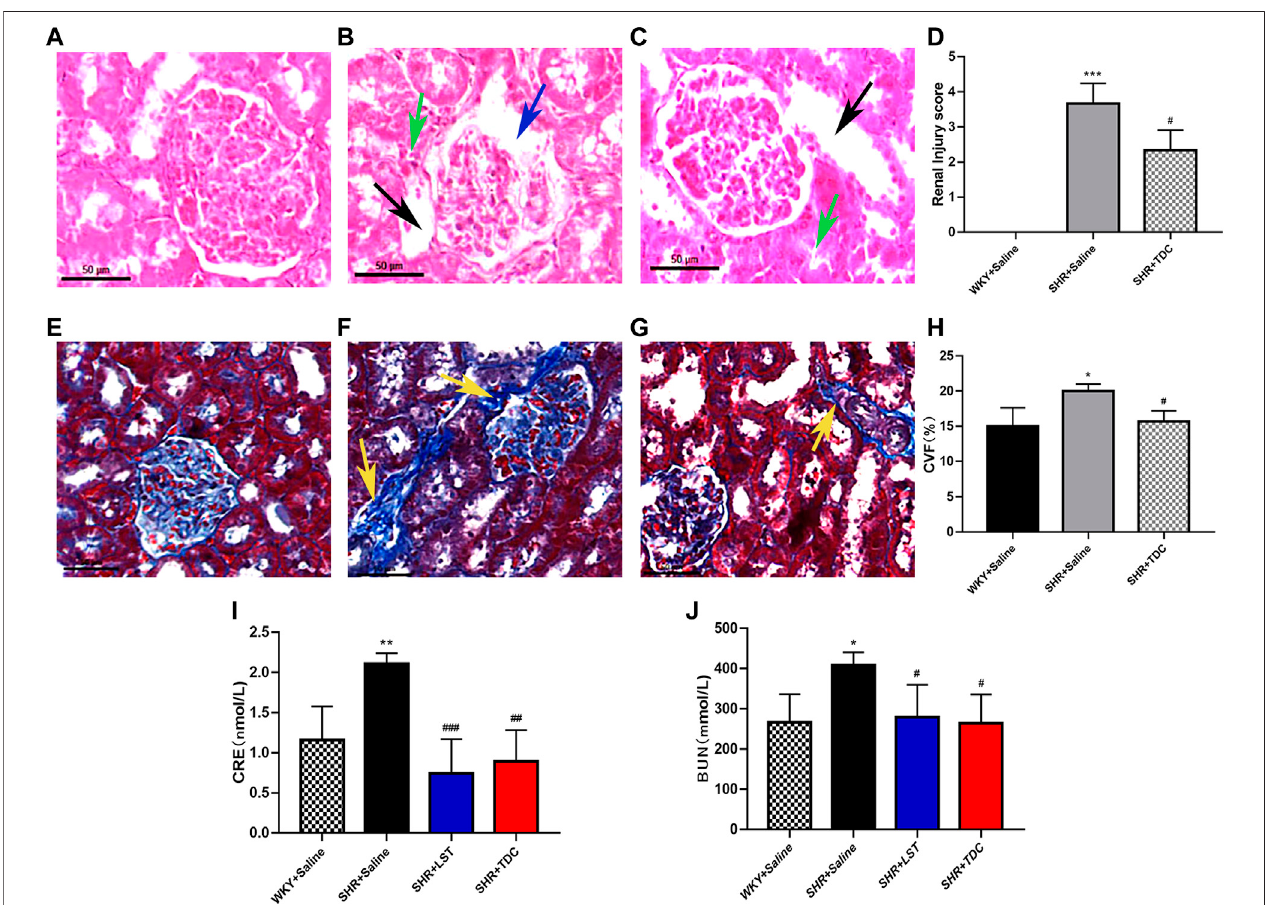
FIGURE 3 | Effect of TDC on hypertension-induced renal injury in SHR (A – J) Panel (A – C) , Representative H and E staining photomicrographs of histopathological changes of renal cortex among different groups ( × 200 magni fi cation) (A) Saline-treated WKY rats, showing normal architecture (B) Saline-treated SHR showing glomerular shrinkage and thickening of the basement membrane (blue arrows), with renal tubules dilation (black arrows) and tubular atrophy (green arrows) (C) TDC- treatedSHRshowingasigni fi cantreductionofglomerularshrinkageandthickeningofbasementmembraneinthefocalarea (D) BargraphcomparisonoftheRenal Injuryscoreinthethree ratgroups.Dataareexpressed asmean ± SD, n (cid:2) 3.*** p < 0.001vs.WKYrats; # p < 0.05vs.SHR(Saline). Panel (E – G ),RepresentativeMasson staining photomicrographs of histopathological changes of renal cortex among different groups ( × 200 magni fi cation) (E) Saline-treated-WKY rats, showing normal architecture (F) Saline-treated SHR showing a signi fi cant increase in collagen fi bers (yellow arrows) (G) TDCs-treated SHR showing obvious reduction of fi brosis in the focalarea (H) BargraphcomparisonoftheCollagenvolumefraction(CVF)levelsinthethreeratgroups.Dataareexpressedasmean ± SD, n (cid:2) 3.* p < 0.05vs.WKYrats; # p < 0.05 vs. SHR (Saline). Panel (I – J) , Bar graph comparison of the levels of CRE and BUN in the four rat groups. Data are expressed as mean ± SD, n (cid:2) 4 – 5. * p < 0.05 ** p < 0.01 vs. WKY rats; # p < 0.05 ## p < 0.01 ### p < 0.001 vs.